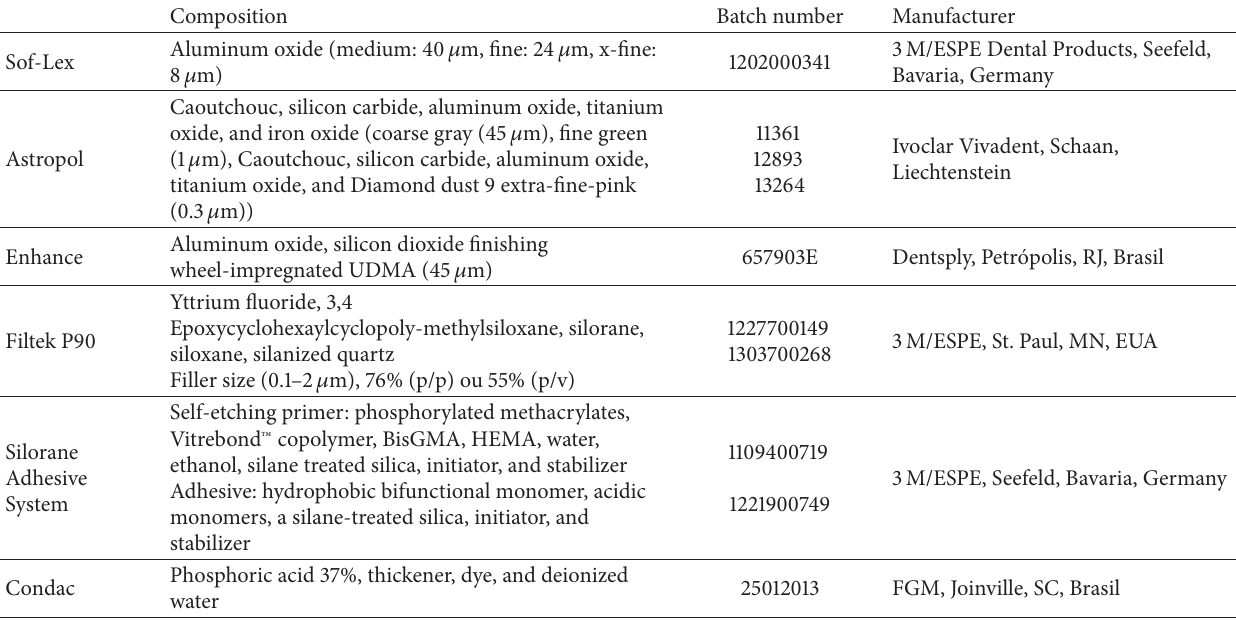
Table 1: Compositions, batches, and manufacturers of the studied